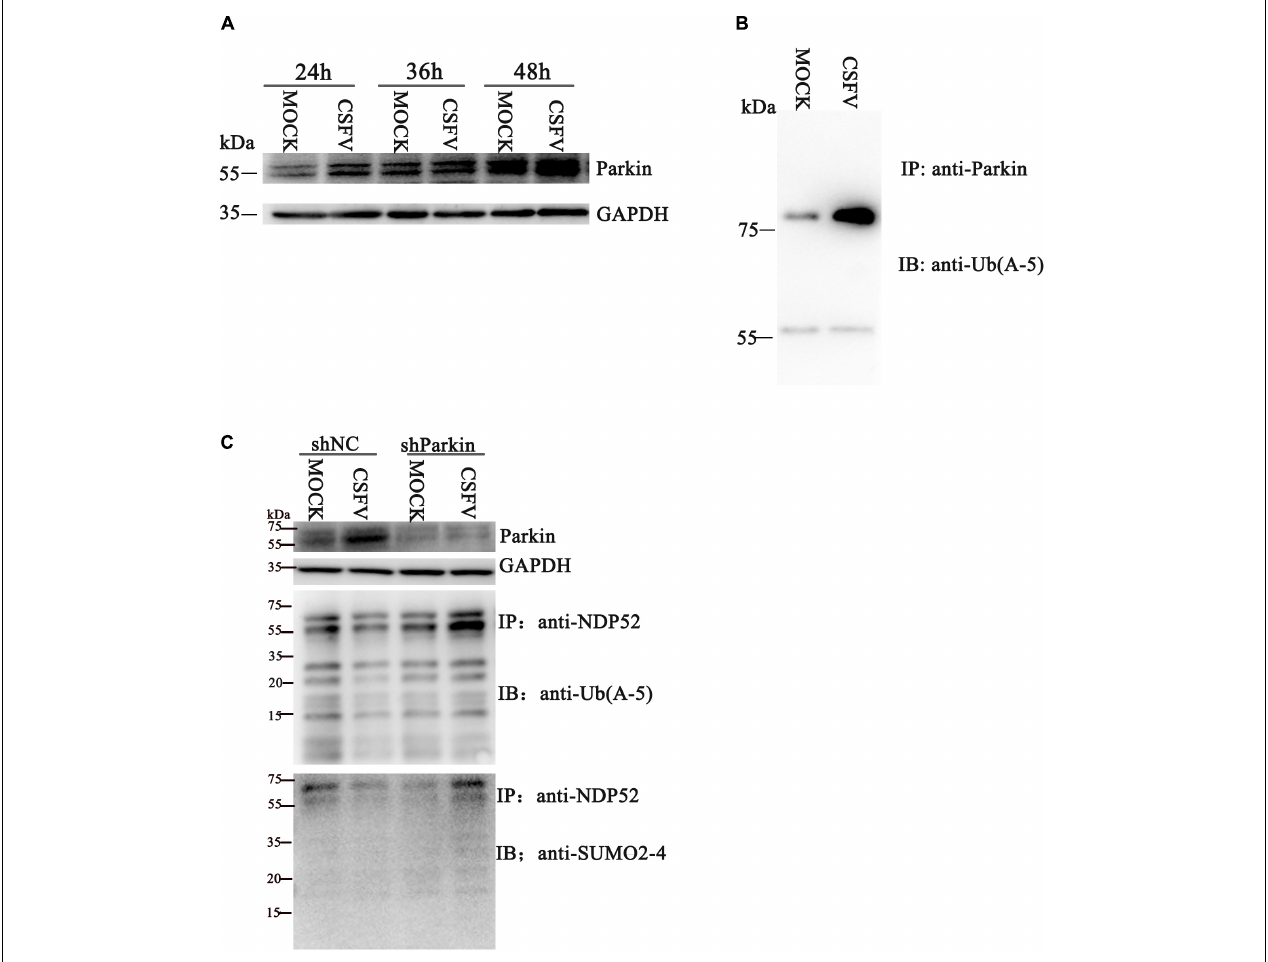
FIGURE 2 | CSFV infection promotes ubiquitination of Parkin2 and mediates NDP52 modification via the PINK1-Parkin pathway. (A) PK-15 cells were treated as in Figure1 A . Western blotting was used to examine Parkin2, N pro and GAPDH protein expression 24, 36, and 48 h after CSFV infection. (B) PK-15 cells were infected with CSFV (MOI = 0.1) for 24 h. Cell lysates were immunoprecipitated with an anti-Parkin antibody and assayed for Parkin2 with anti-Ub(A-5) antibody. (C) PK-15 cells were infected with CSFV (MOI = 0.1) for 24 h, followed by shParkin2 or shNC plasmid (MOI = 10) for 24 h. After immunoprecipitation with an anti-NDP52 antibody, NDP52 ubiquitination and SUMOylation were blotted with anti-Ub-5a and anti-SUMO2-4